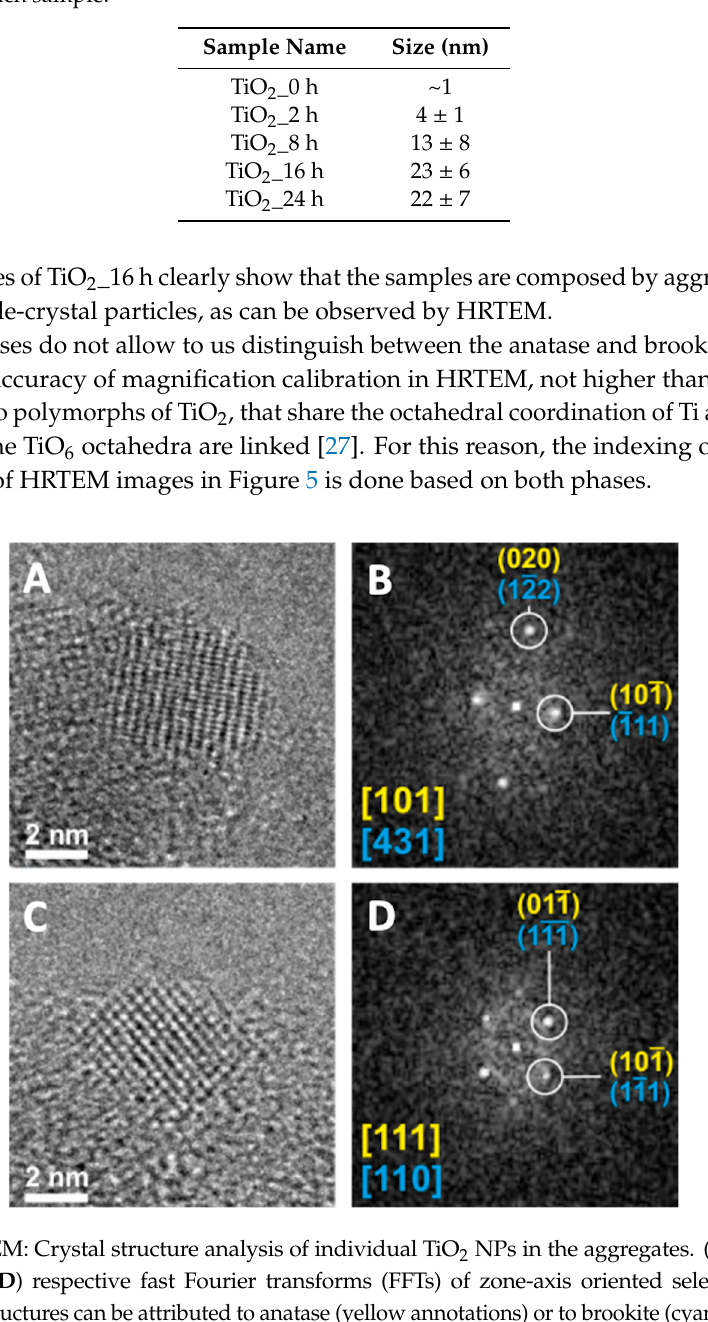
Figure 4. TEM micrographs of synthesized TiO 2 NPs before (( A ), TiO 2_ 0) and after the thermal treatment at 110 °C in an oven carried out for 2 h (( B ), TiO 2_ 2 h), 8 h (( C ), TiO 2_ 8 h), 16 h (( D ) TiO 2_ 16 h) and 24 h (( E ), TiO 2_ 24 h). SEM micrograph of TiO 2 NCs aggregates after 16 h of thermal treatment at 110 °C in oven ( F ). Table 2. Statistical evaluation of TiO 2 NPs size after the thermal treatment at 110 °C in oven carried